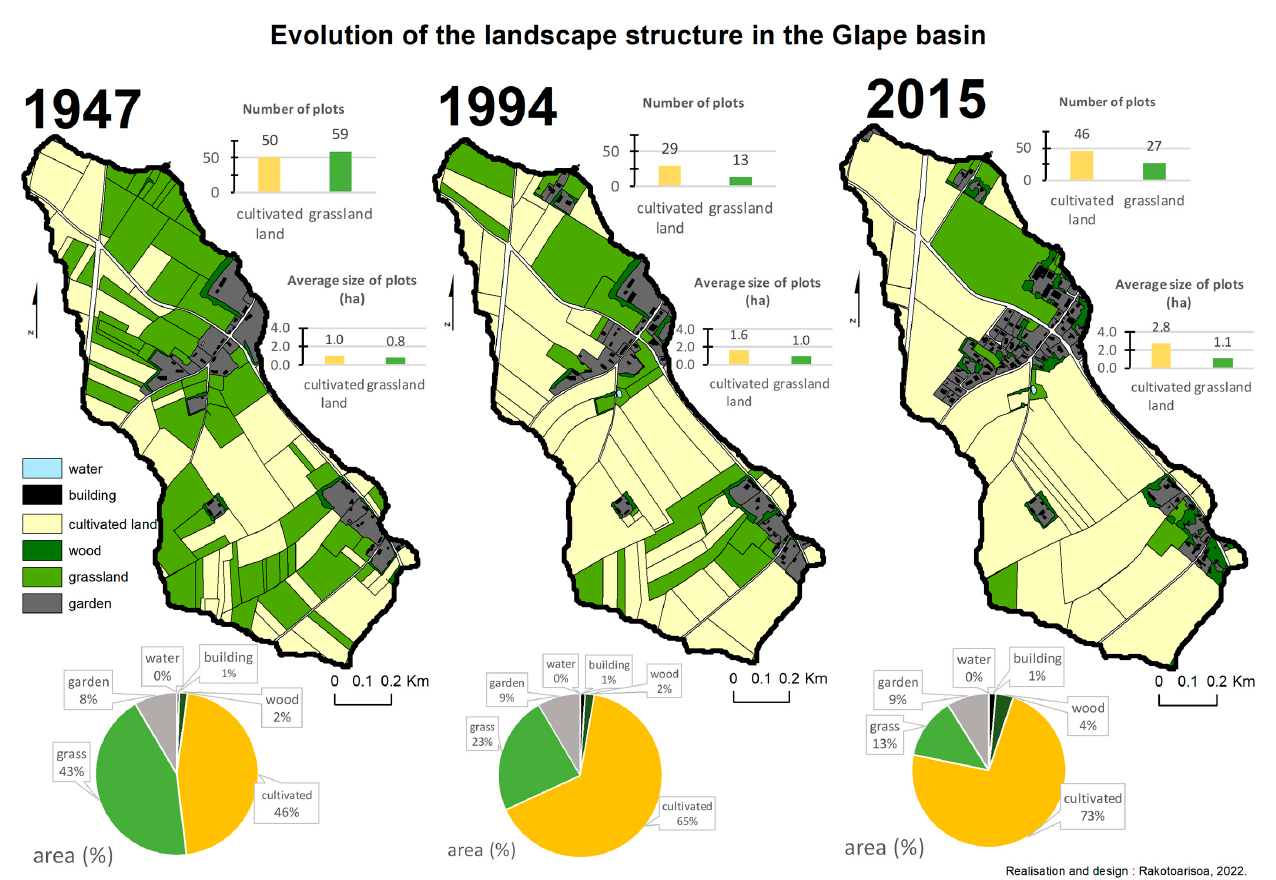
Figure 8. Evolution of the landscape structure in the Glape basin.